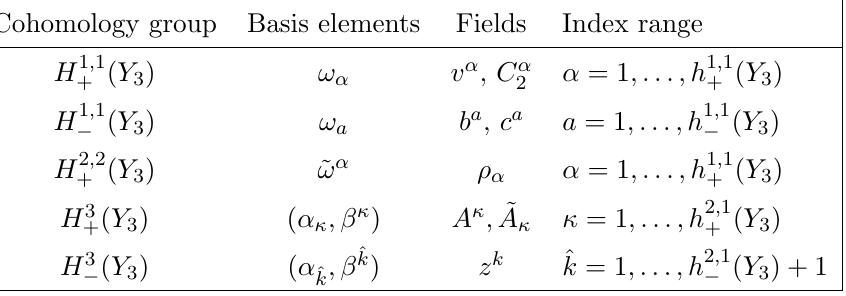
Table 1 . Real basis for the cohomology groups. The dimensions are denoted by h p;q dim H p;q ( Y 3 ). ( (cid:11) (cid:20) ; (cid:12) (cid:20) ) and ( (cid:11) ^ ; (cid:12) ^ k ) are symplectic basis. Our index conventions include k (cid:6) k